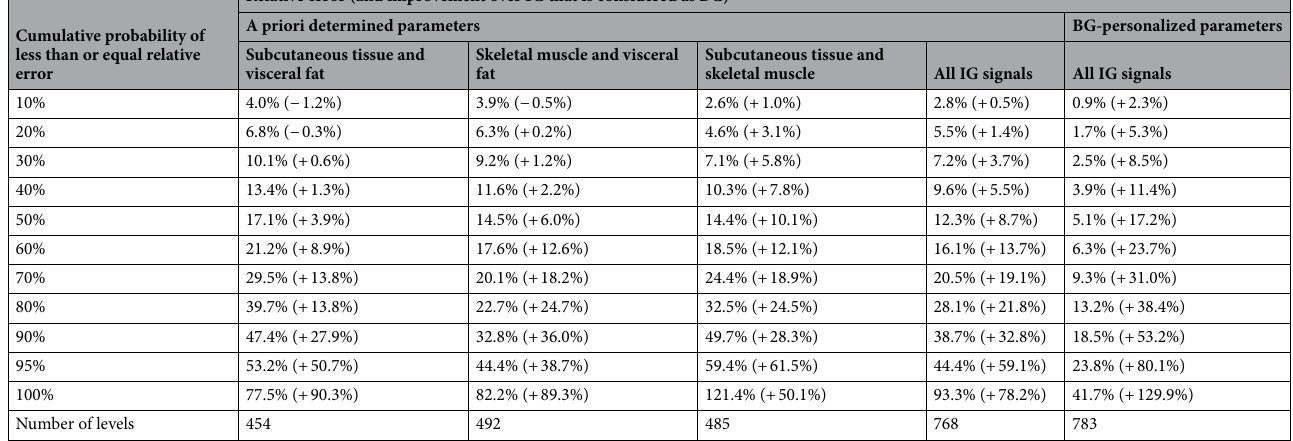
Table 3. Scenario b), calculated single BG using multiple IG